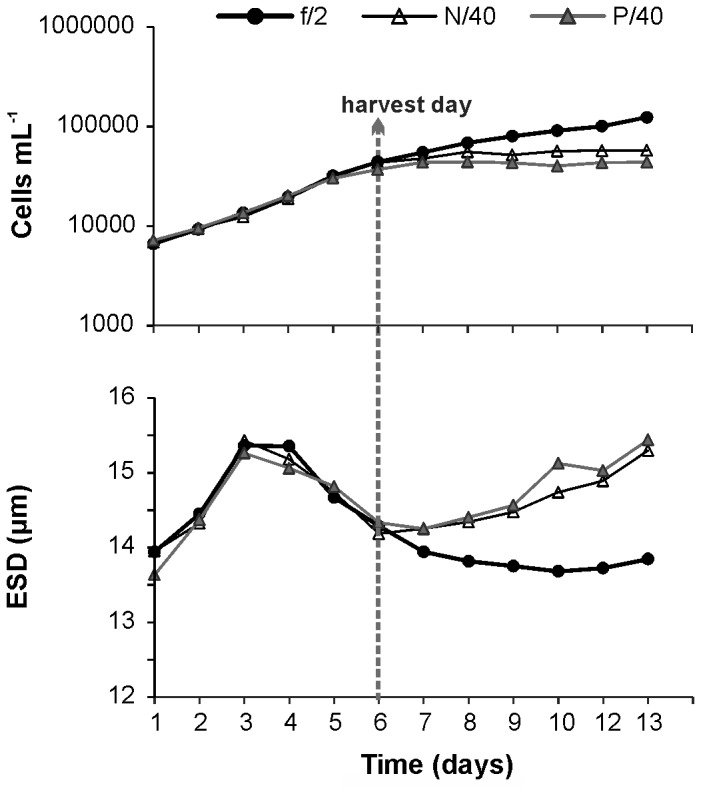
Growth of the Heterocapsa sp. cultures.Temporal evolution of cell concentration and size (ESD, equivalent spherical diameter) of the autotrophic dinoflagellate Heterocapsa sp. when cultured under three nutrient treatments (f/2: nutrient-replete, N/40: nitrogen-depleted, P/40: phosphorus-depleted). Vertical dashed line indicates the "harvest day" (the day that cells were collected for staining and experiments; notice that cell size among treatments was still the same).